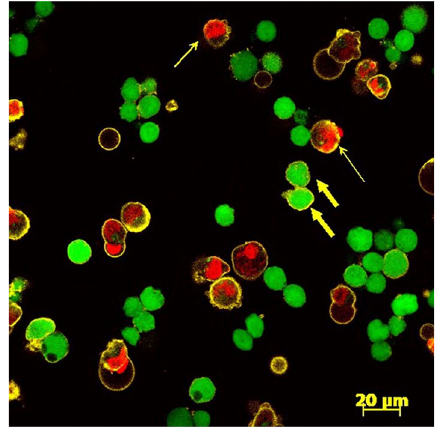
Figure 2. Non-adhered HLEC exposed to 0.001% ZDEC. Representative confocal laser scanning micrograph showing the effect of 0.001% ZDEC on distributions of live (green), dead (red), early apoptotic (green with yellow ring), and late apoptotic (red with yellow ring) cells. A closer look at the apoptotic phenomenon is shown where the wide arrow indicates early apoptosis and narrow arrow indicates late apoptosis.